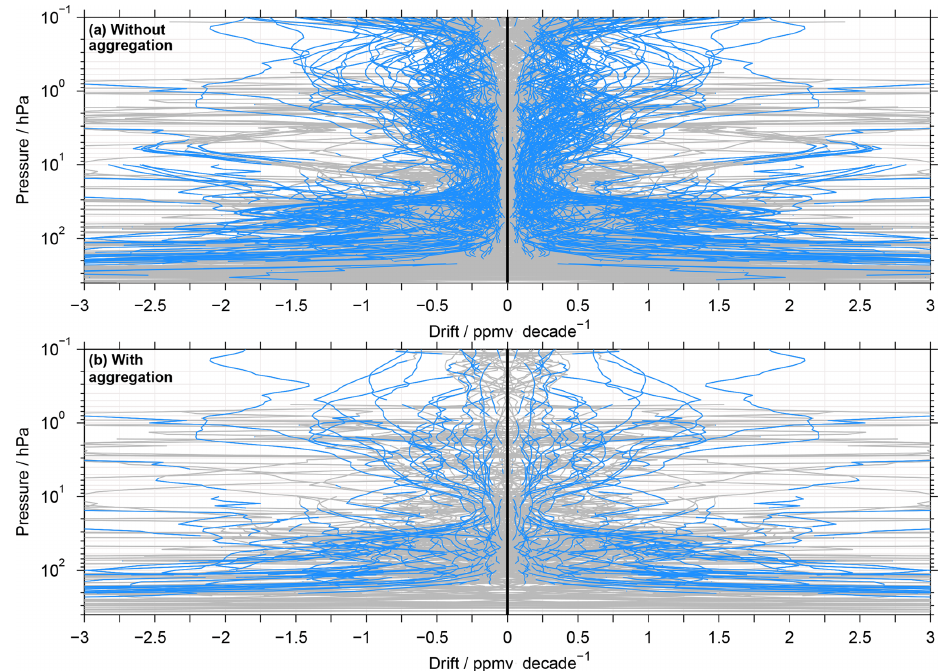
Figure 11. Drift results for the full matrix of comparisons considering coincident observations during all seasons and at all latitudes. Drifts that are statistically significant at the 2 σ uncertainty level are marked in light blue. Panel (a) shows the picture without the aggregation of the MIPAS results, while (b) considers this aggregation.